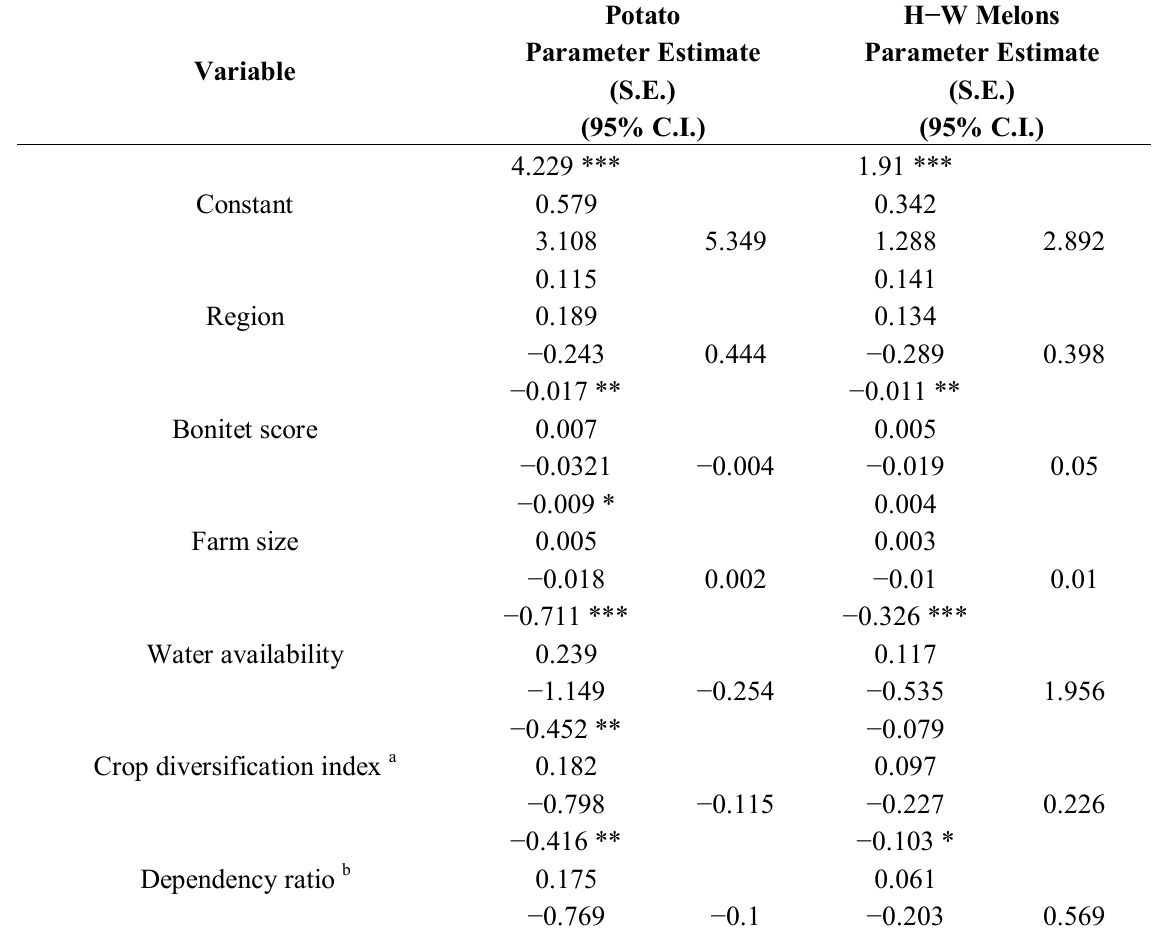
Table 4. Results from the double bootstrapping